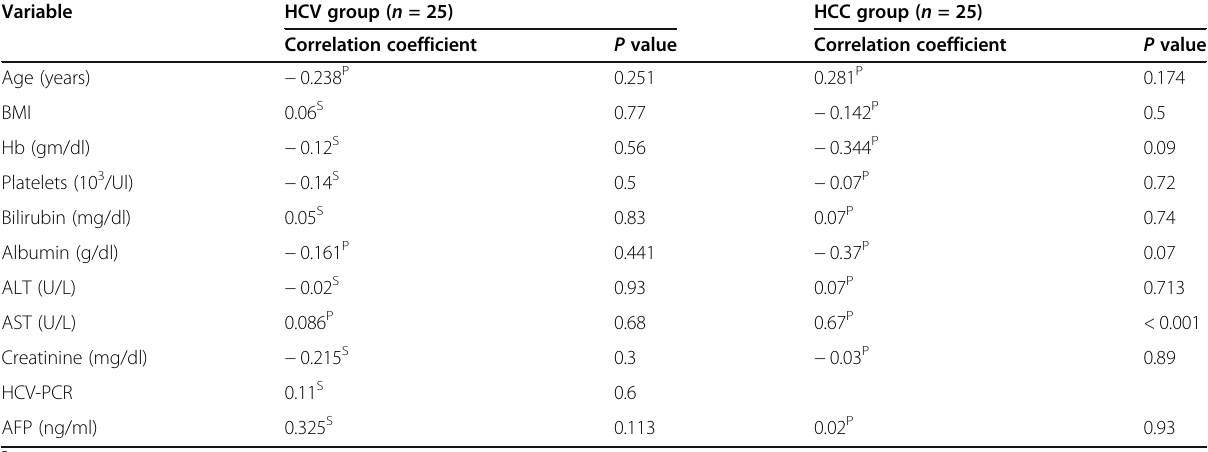
Table 2 Correlation between baseline VEGF and laboratory findings in both groups Variable